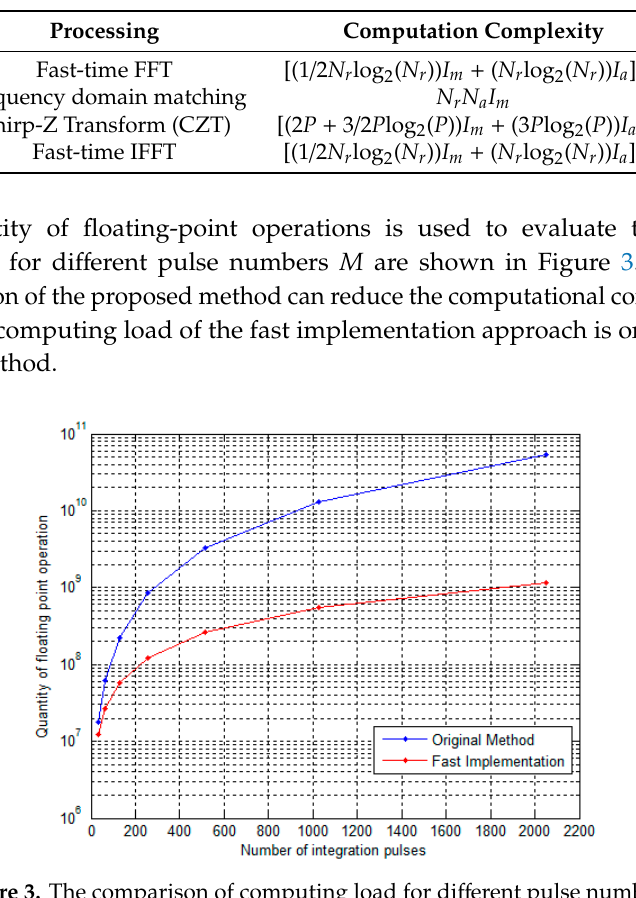
Table 1. Computing load analysis.